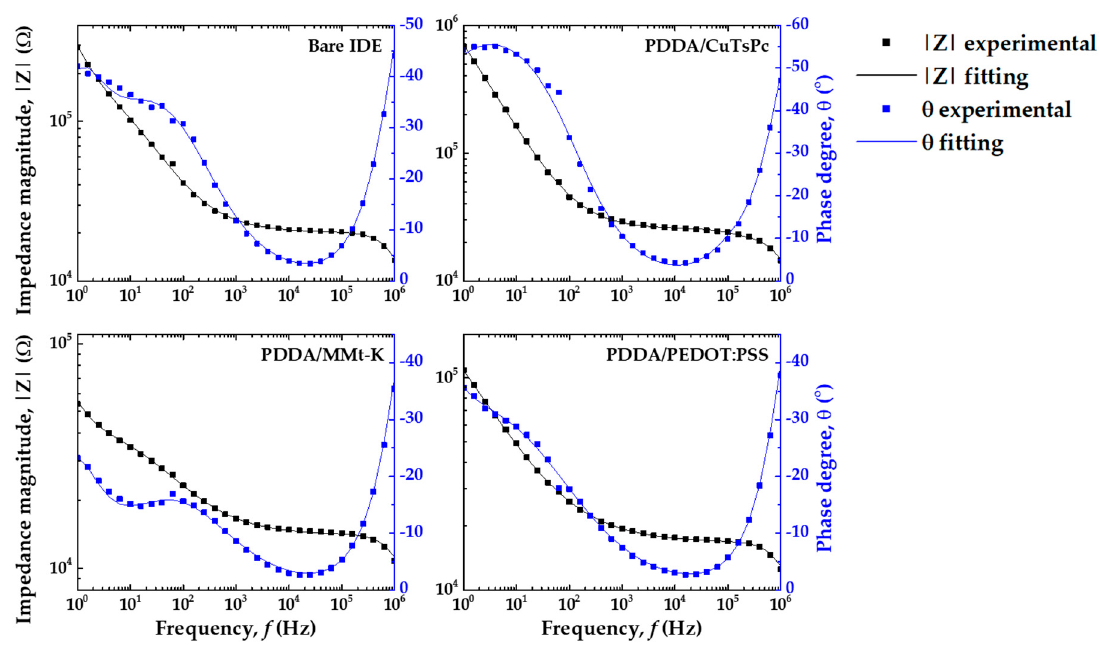
Figure 13. Measured (square) and fitted (line) Bode diagrams for bare IDE, PDDA / CuTsPc, PDDA / MMt-K, and PDDA / PEDOT:PSS sensing units in Zero-Cal ® aqueous solution (10 µ L / mL) at 5 mL / h flow rate.